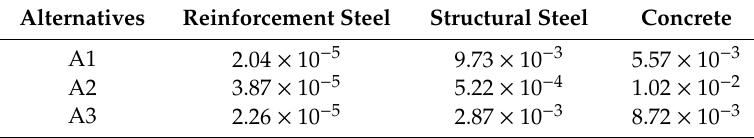
Table 6. Initial data for multi-criteria analysis.